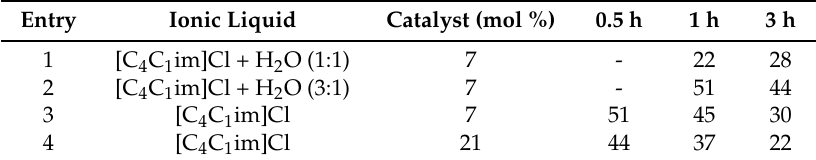
Table 2. Effect of addition of water and catalyst loading on HMF formation (%) at 150 ◦ C.